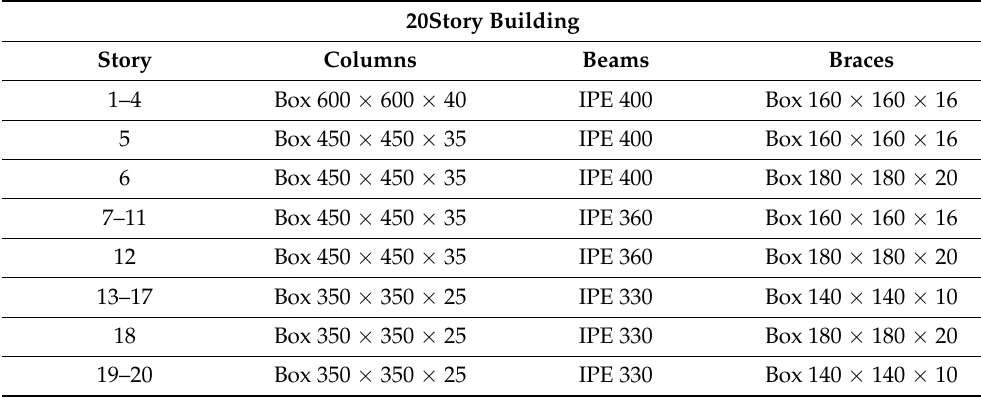
Figure 23. Schematic view of the side 20-story frame in ETABS. Table 4. Sections used in structural frames selected from existing buildings. Modes have been considered and the results have been compared with each